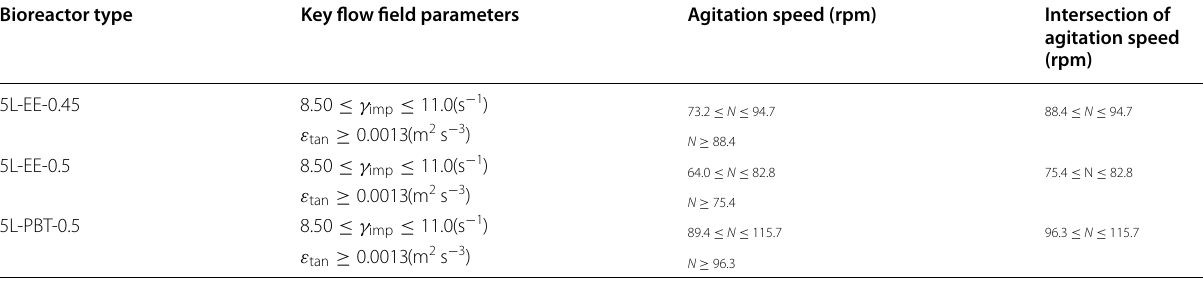
Table 2 Ranges of agitation speeds for BHK-21 cells cultured in the different 5-L bioreactors as required by the optimal key hydrodynamic